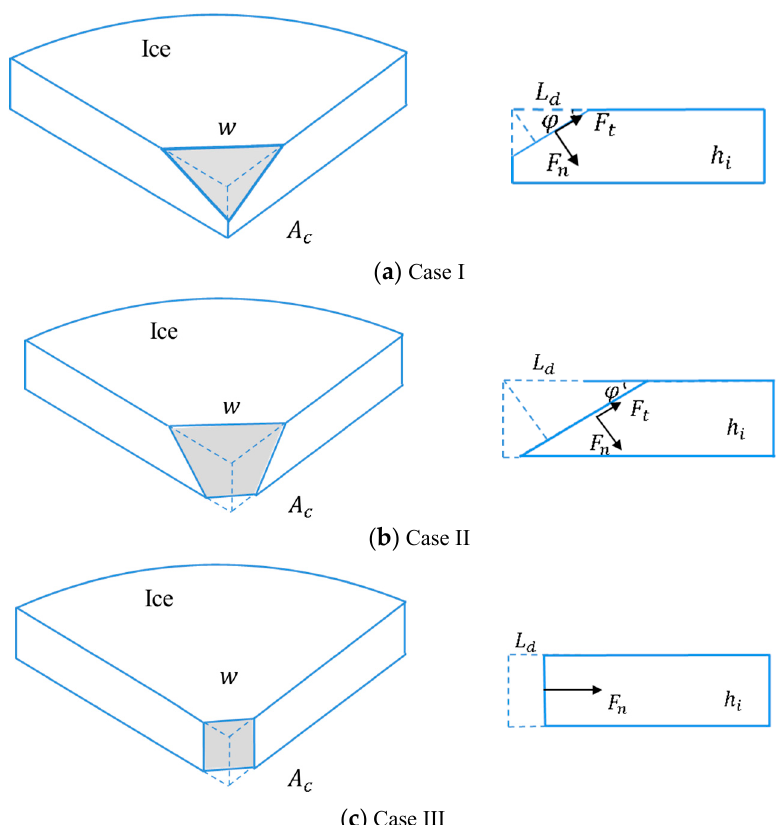
Figure 5. View of the ice–structure contact area.